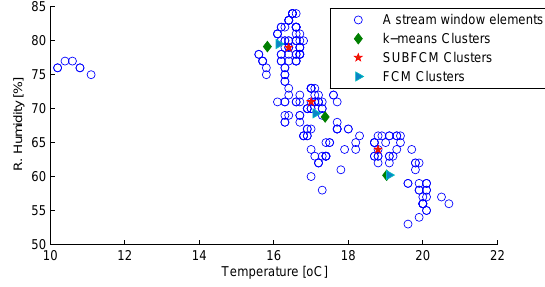
Figure 6. Stream sets and clusters from the first simulation